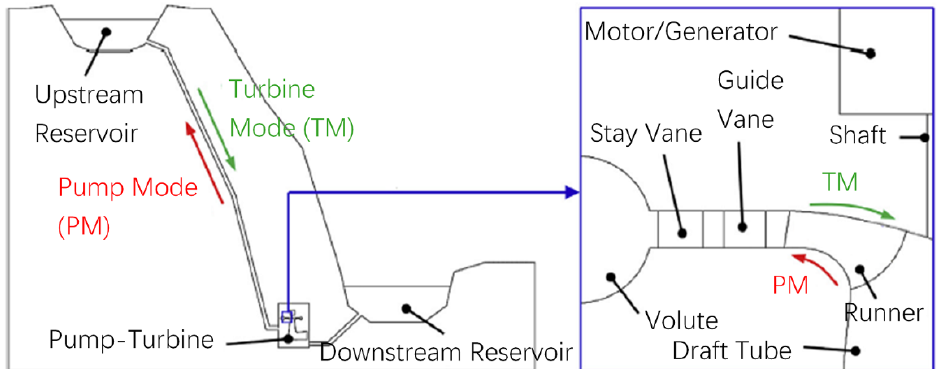
Figure 1. Schematic Map of the Pumped Storage Hydro Unit.